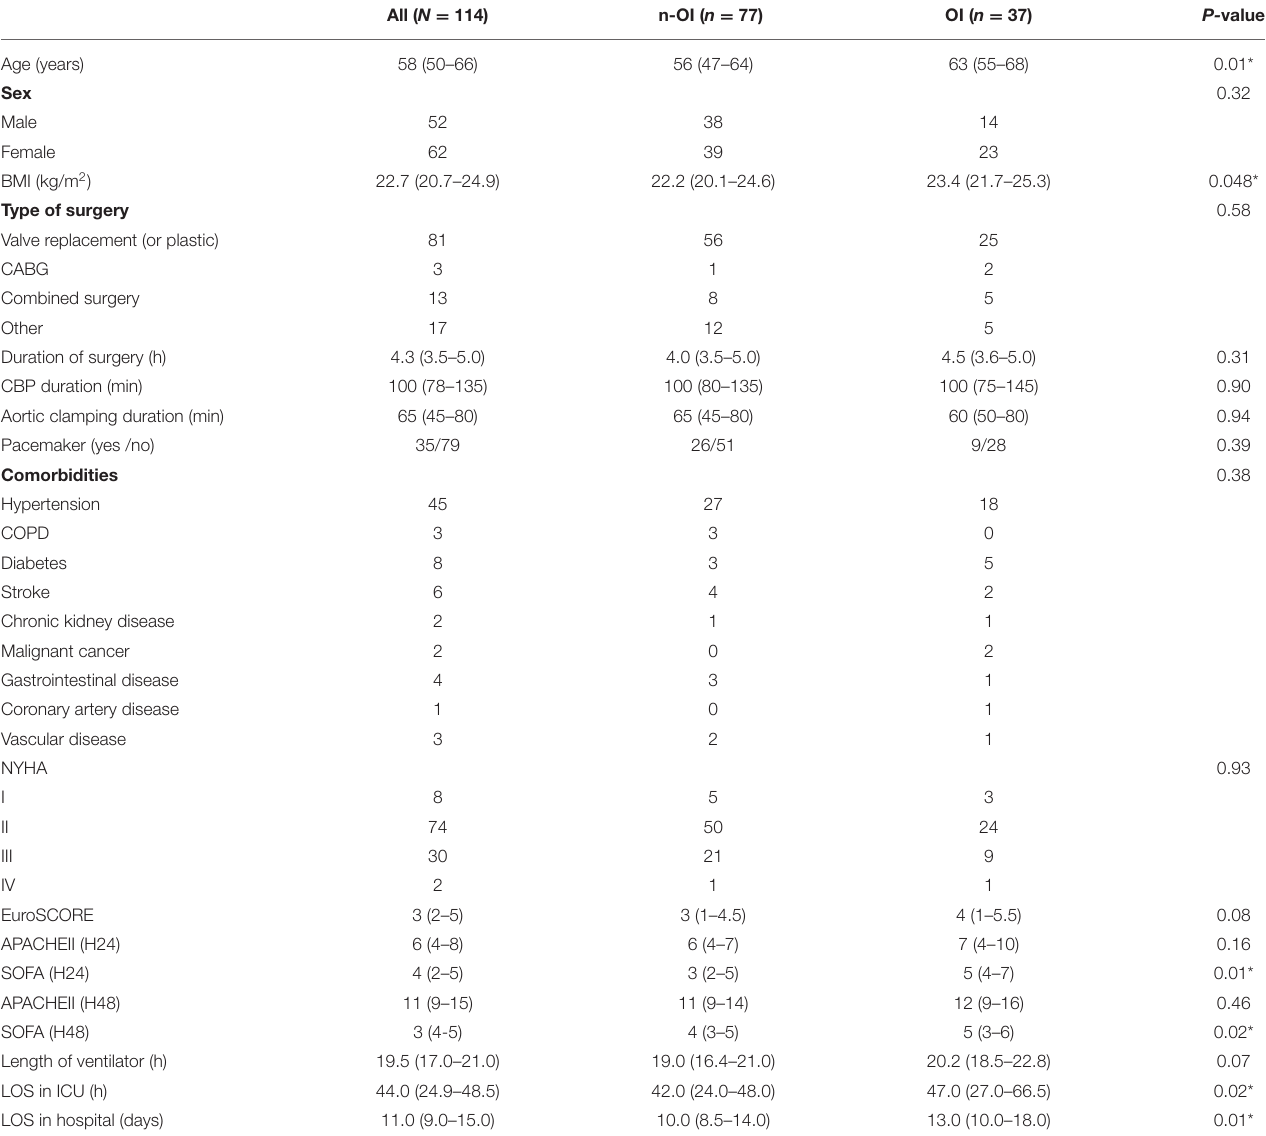
TABLE 1 | Clinical characteristics and prognosis of patients in the n-OI and OI groups ( N =